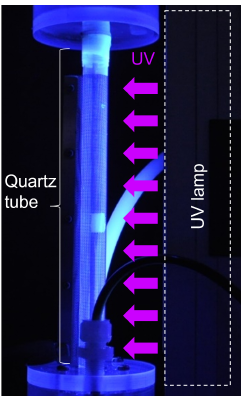
Figure 6. Typical in situ fluorescence image of 2-hydroxyterephthalic acid (HTA) induced by UV-light irradiation. The streamer discharges were generated by nanosecond-pulsed voltage whose peak value and repetition frequency were 24 kV and 100 pps, respectively, and were irradiated to the 2 mM disodium terephthalate (NaTA) solution.